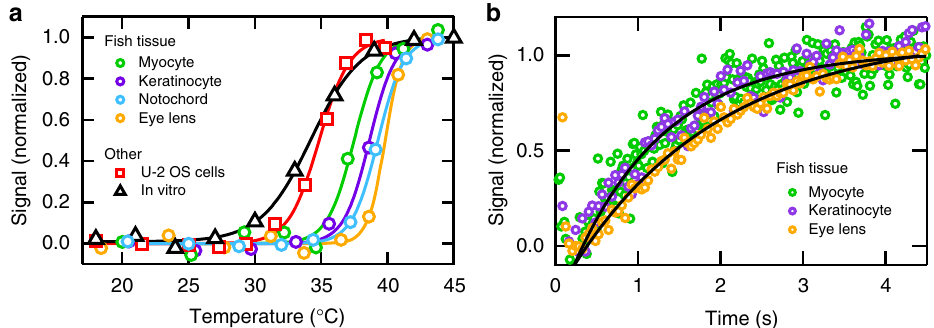
Fig. 3 Representative thermal denaturation and relaxation kinetics traces of PGK in different tissues. a Representative thermal denaturation of PGK FRET monitored by fl uorescence microscopy. The signal from two-color FRET experiments is reported as normalized donor/acceptor ratio. The complete denaturation pro fi le between 18 and 45 °C monitored in zebra fi sh tissue (circles): myocyte (green), keratinocytes (purple), notochord (blue), or eye lens cells (orange); U-2 OS mammalian cells (red squares); or in vitro (black triangles). A sigmoidal fi t is overlaid on the data. Source data are provided as a Source Data fi le. b Representative relaxation kinetics of PGK following a temperature jump to T m observed by fl uorescence microscopy. The signal from two-color FRET experiments is reported as normalized donor/acceptor ratio: myocyte (green), keratinocytes (purple), or eye lens cells (orange). A single- exponential fi t is overlaid on the data between 200 ms and 4.4 s. Data below 200 ms was not used due to re fl exive motion of the zebra fi sh. Source data